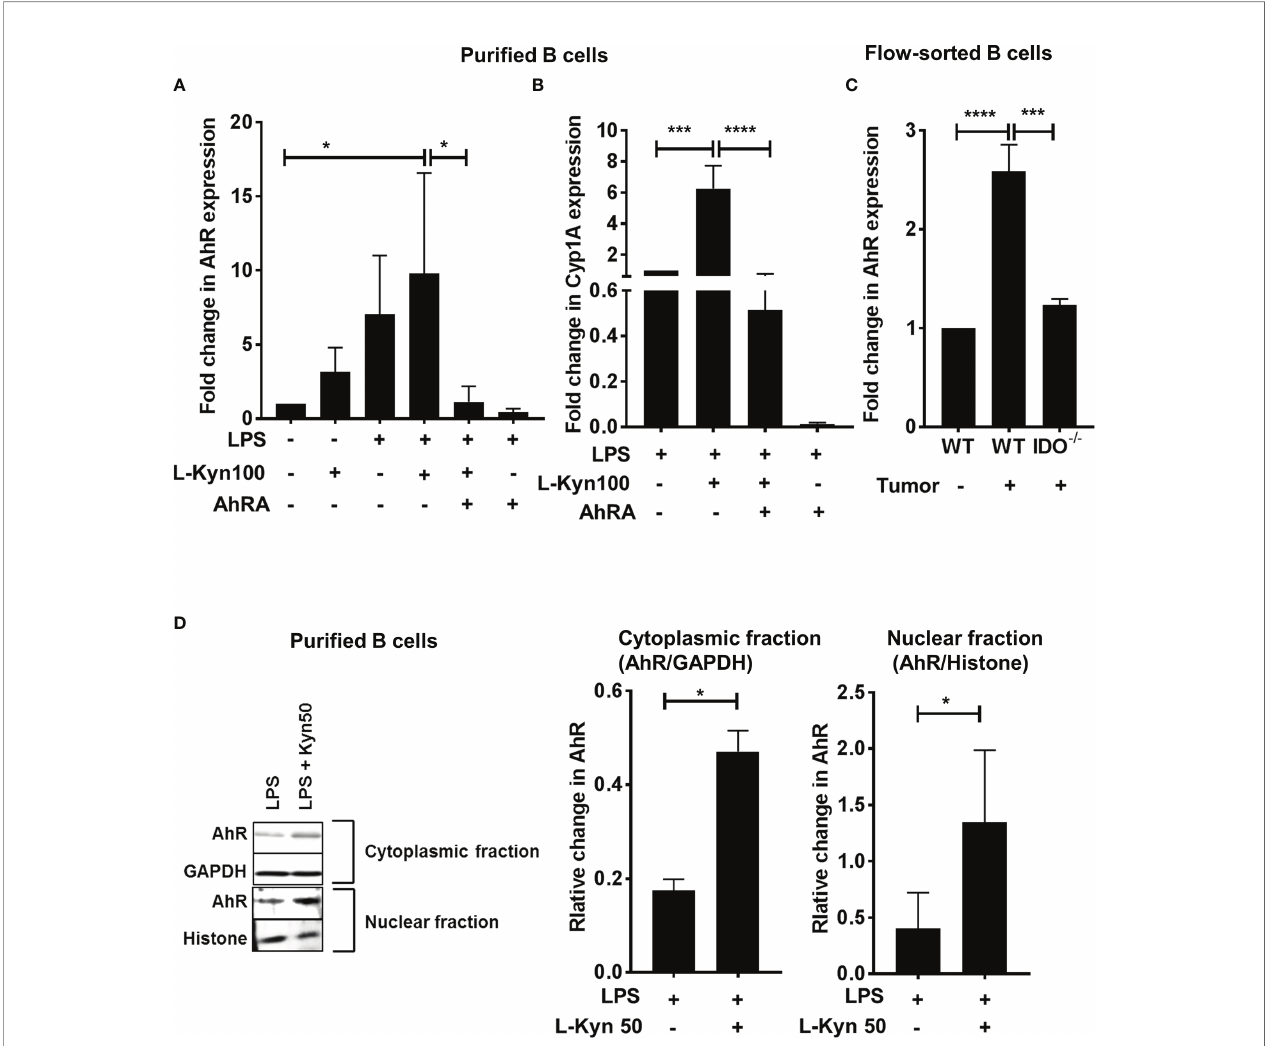
FIGURE 4 | Trp metabolite L-Kyn activated AhR pathway. CD19 + B cells were negatively selected from whole splenocytes of WT mice, disaggregated and seeded with LPS (10 m g/ml), L-Kyn (50µM and 100 m M) and LPS + L-Kyn + CH 223191(10 m M) an aryl hydrocarbon receptor antagonist (AhRA) for 72 hrs (A) AhR expression was assessed by qRT-PCR in the cells collected from ex-vivo experiments performed with puri fi ed B cells in experimental conditions described above (B) AhR target gene Cyp1A1 expression was assessed by qRT-PCR in puri fi ed B cells ex-vivo experiments following stimulation of LPS, LPS+L-Kyn, LPS+L-Kyn+AhRA and LPS+ AhRA (C) AhR expression was assessed by qRT-PCR in B cells (CD19 + ) sorted from naïve WT, tumor-bearing WT and tumor-bearing IDO -/- mice on Day 9 post tumor implant (D) Cytoplasmic and nucleoplasmic fraction were collected from puri fi ed B cells from ex-vivo experiments following stimulation with LPS and LPS+L- Kyn Western blot analysis was performed to detect AhR expression in cytoplasmic and nucleoplasmic fractions and the relative expression was normalized with GAPDH and histone respectively. *p < 0.05, ***p < 0.0001, ****p <